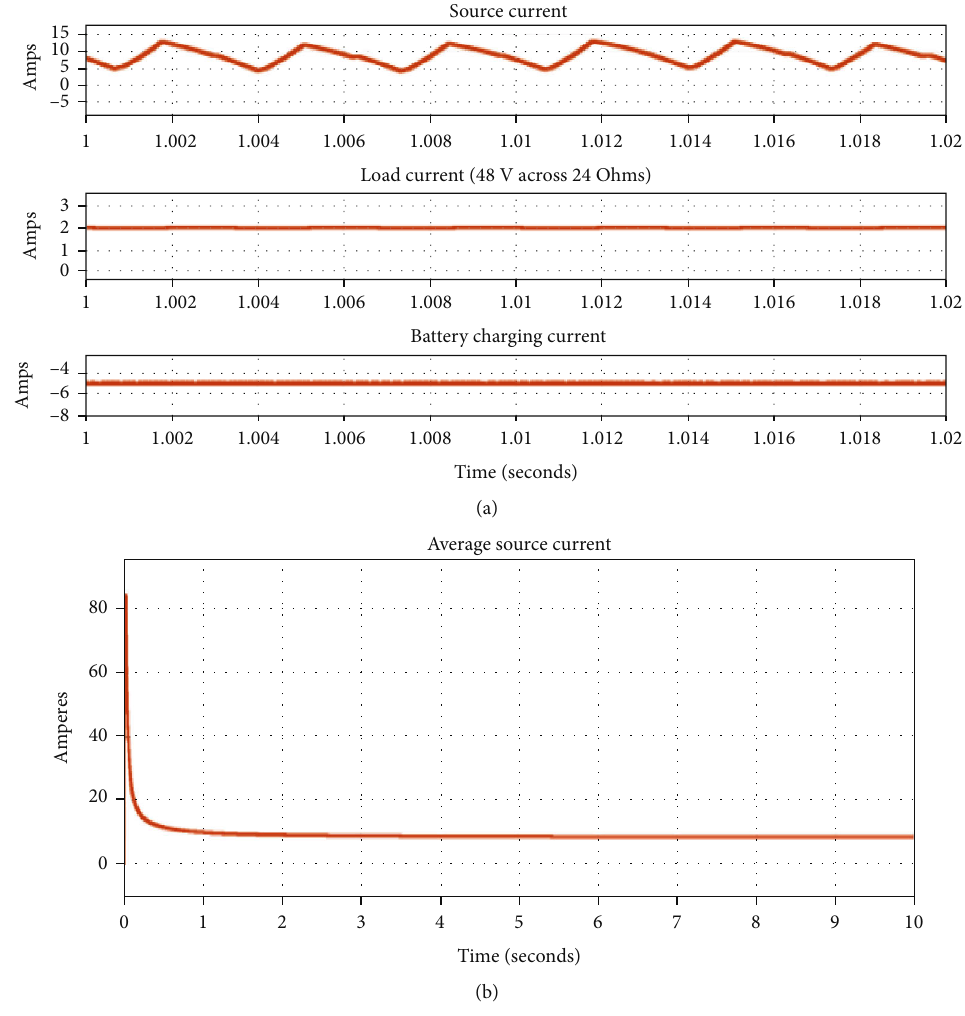
Figure 15: (a) Source, load, and battery currents. (b) The average source